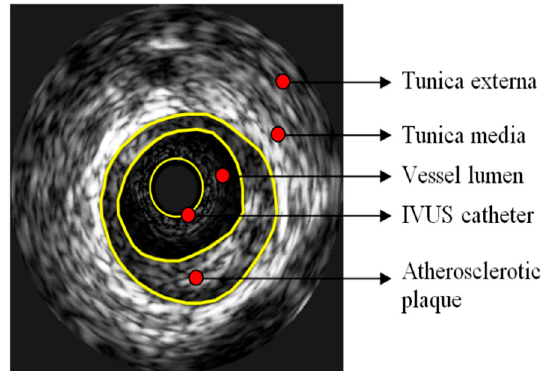
Figure 1. Typical conventional grayscale display of an image acquired through intravascular ultrasound imaging (IVUS). Hippokration Hospital, 1st Department of Cardiology, National and Kapodistrian University of